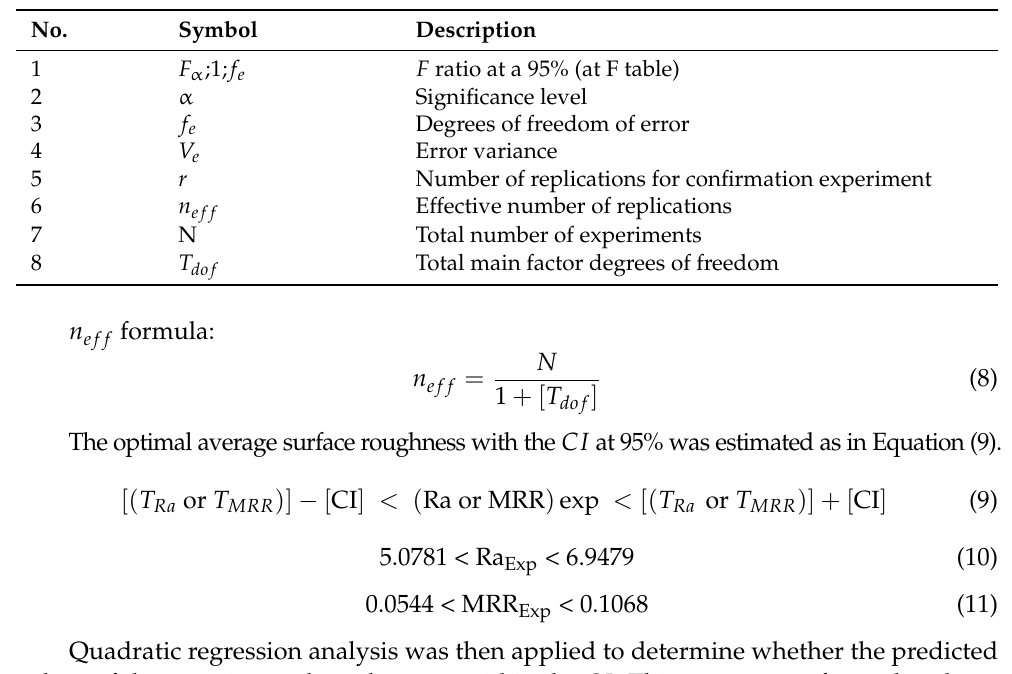
Table 11. Confidence interval ( CI ) formulae symbols